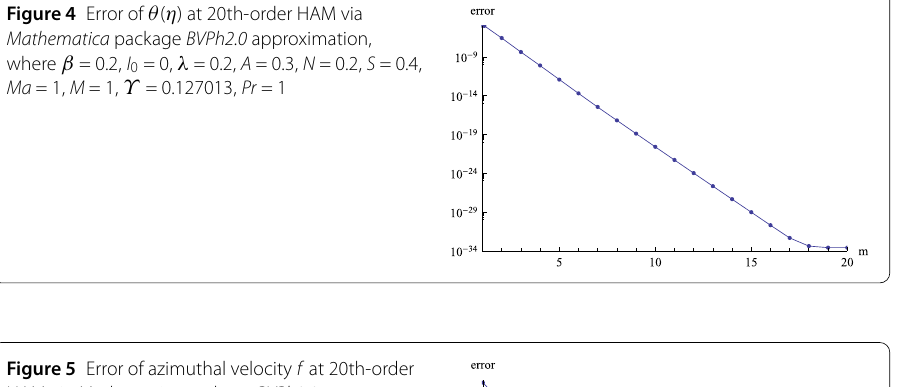
Figure 5 Error of azimuthal velocity f at 20th-order HAM via Mathematica package BVPh2.0 approximation, where β = 1, I 0 = 0, λ = 0.2, A = 0.3, N = 0.2, S = 0.4, Ma = 1, M = 1, Υ = 0.127013, Pr = 1